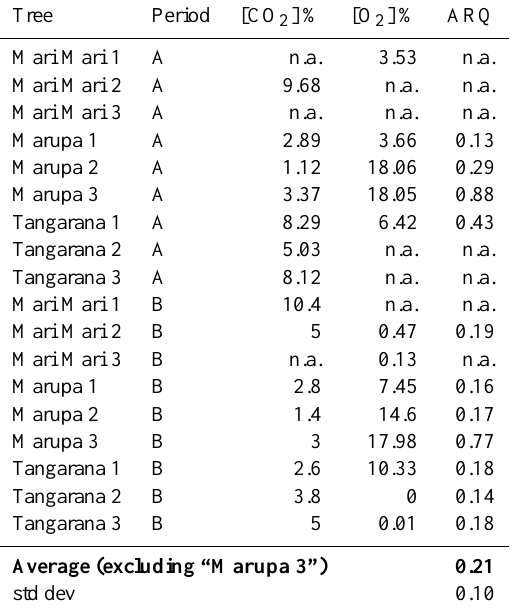
Table 4. Results of in-stem probe sampling. During sampling pe- riod A the gas samplers attached to the probes were opened on 30 September and closed on 29 October 2011. In sampling period B, the gas flasks were attached and opened on 29 October and closed on 6 December 2011. The analytical error in ARQ estimate is 0.01.